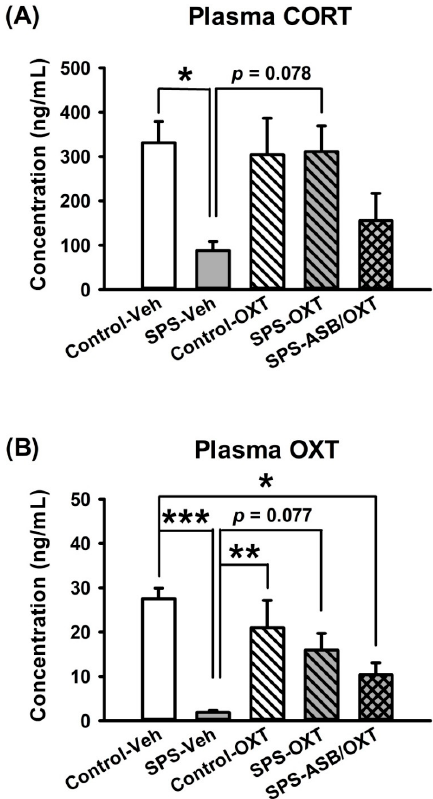
Figure 2. Plasma levels of corticosterone (CORT) and OXT. OXT reversed the SPS (single prolonged stress)-induced reduction of plasma CORT and OXT levels, but ASB blocked it. n = 6 for each group, SPS: single prolonged stress; Veh: vehicle; OXT: oxytocin; ASB: atosiban. Bars represent mean ± SEM; * p < 0.05, ** p < 0.01, *** p < 0.001.